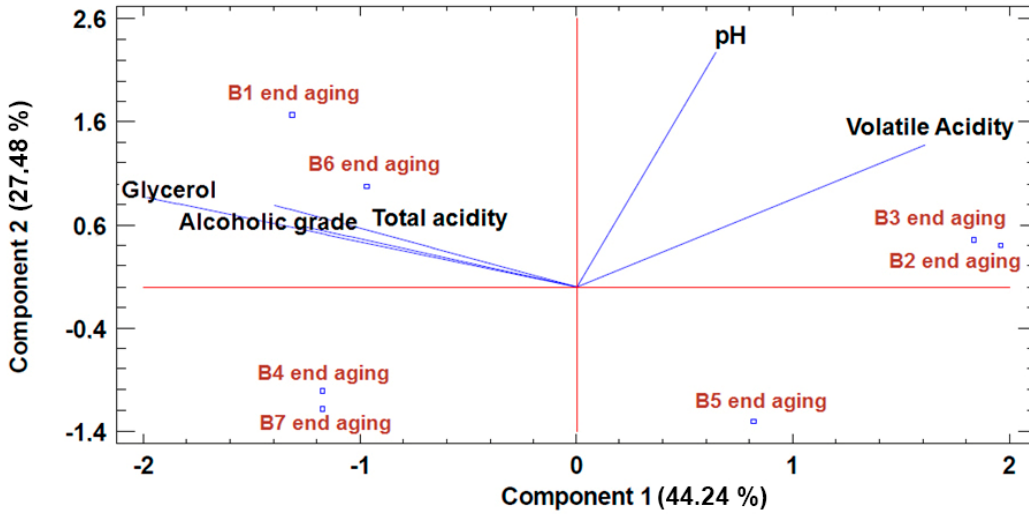
Figure 3. PCA of the parameters pH, alcohol content, volatile acidity, total acidity, and glycerol of the wines aged in the barrels studied.